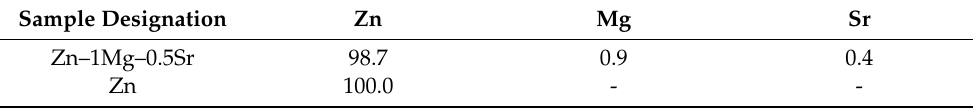
Table 1. Chemical composition of Zn–1Mg–0.5Sr alloy